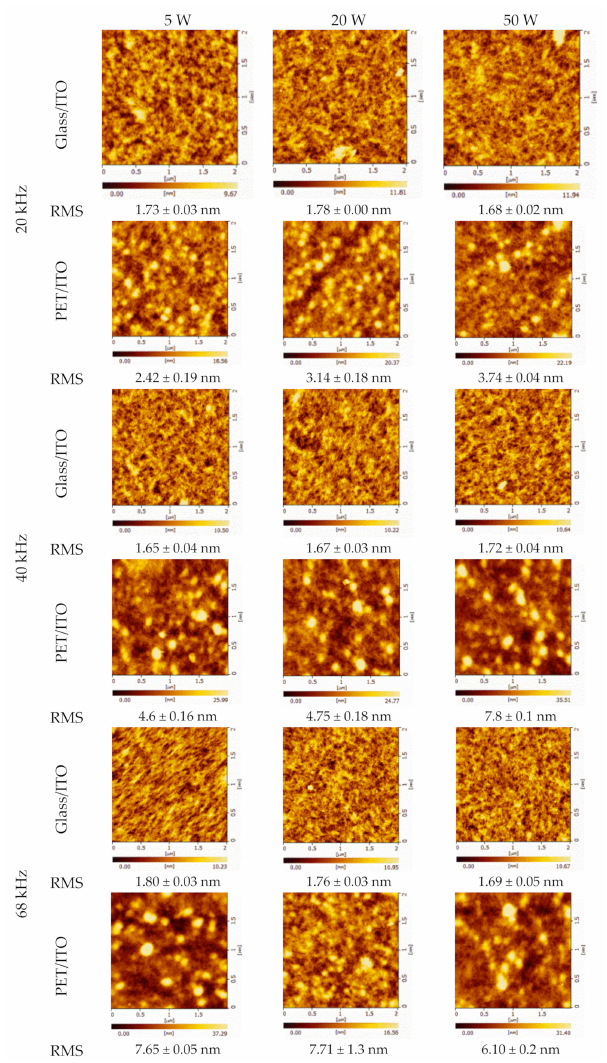
Figure 4. AFM height images showing the effect of varying vibration power and frequency on the film topography and RMS roughness of PEDOT:PSS films treated by the SVPT. This figure also studies the effect of using rigid (glass/ITO) and flexible plastic (PET/ITO) substrates on the film morphology and roughness. The corresponding phase images are shown in Figure S3 of supporting